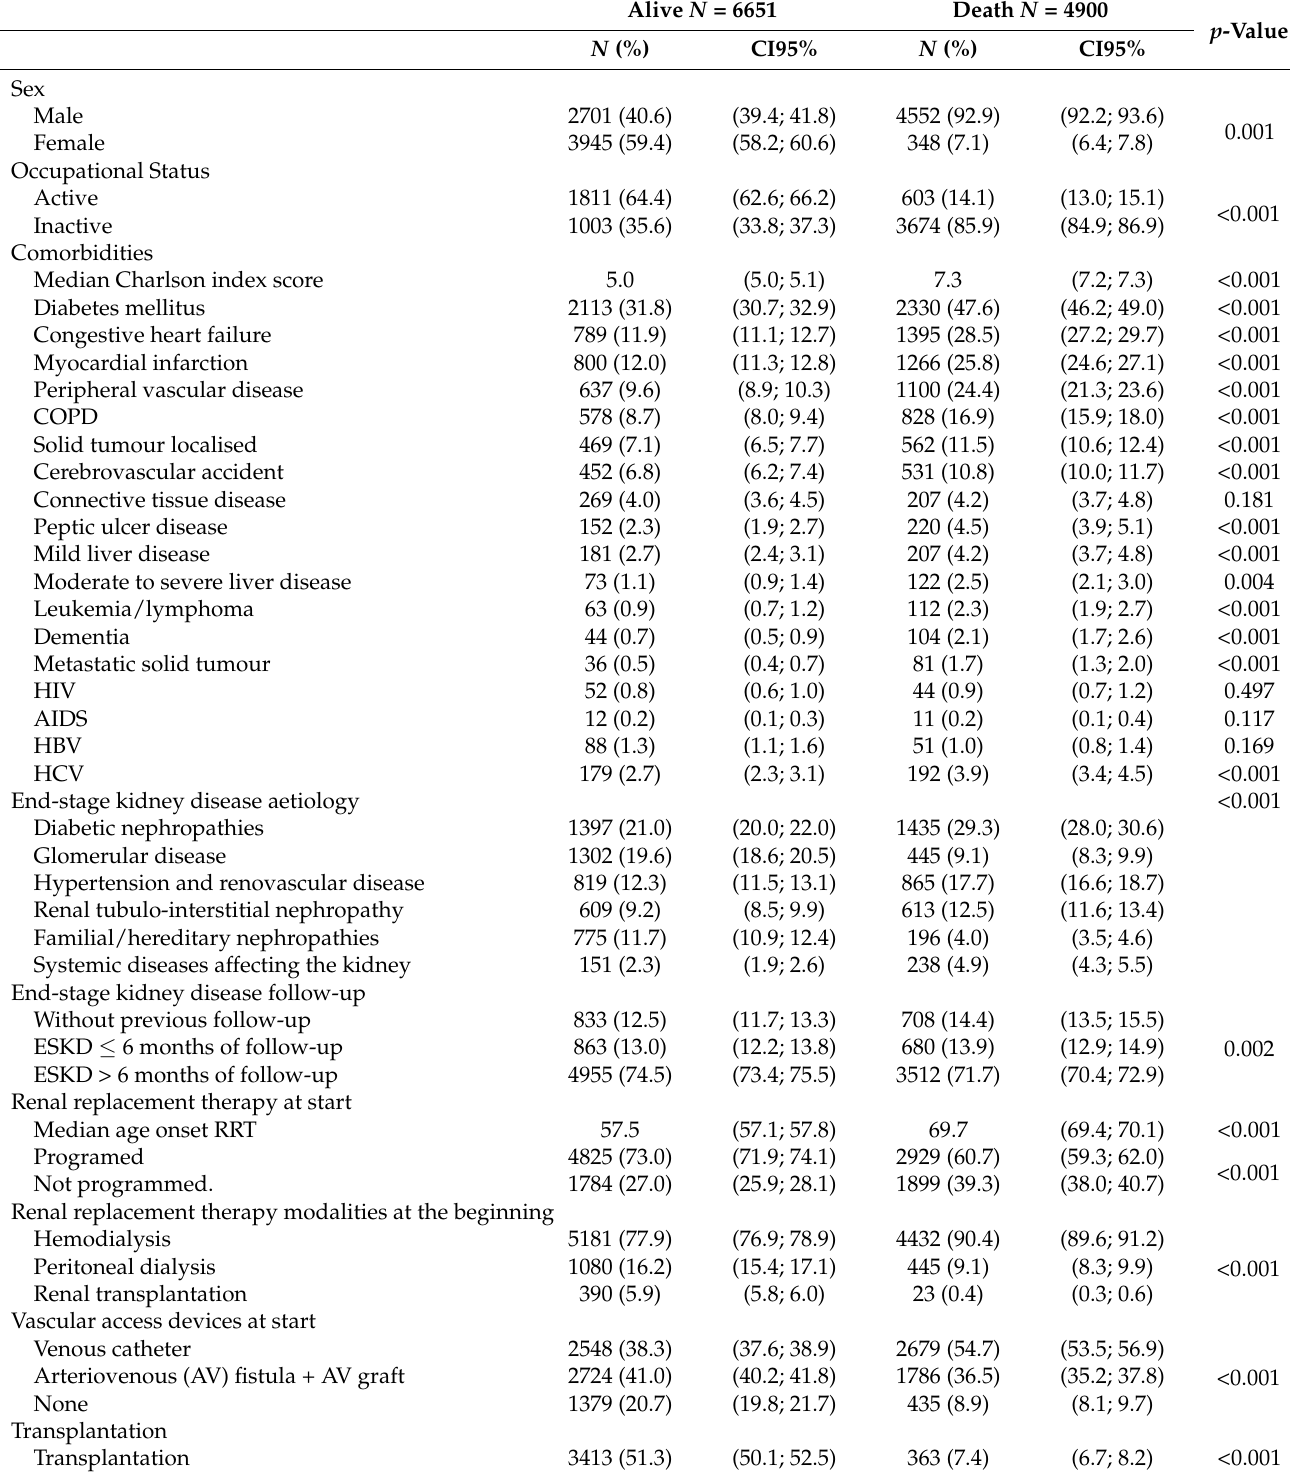
Table 3. Patient characteristic assessment related to